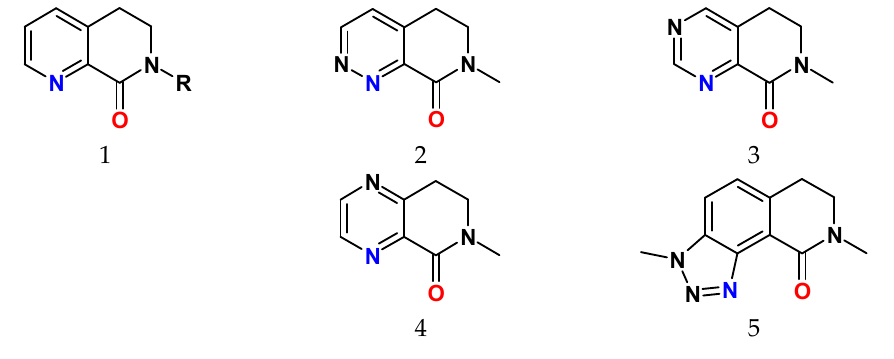
Figure 7. Structures of studied lactams.